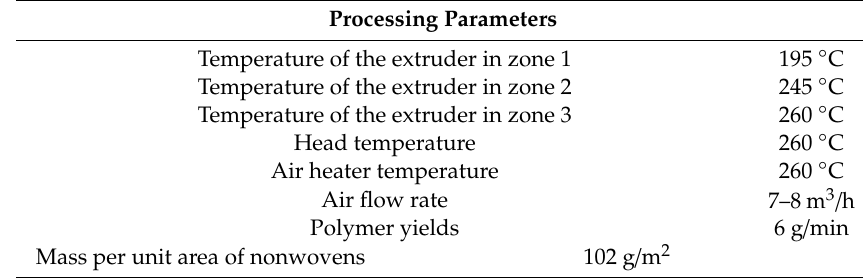
Table1. ProcessingparametersusedtopreparePLAcompositenonwovensbythemelt-blowntechnique.